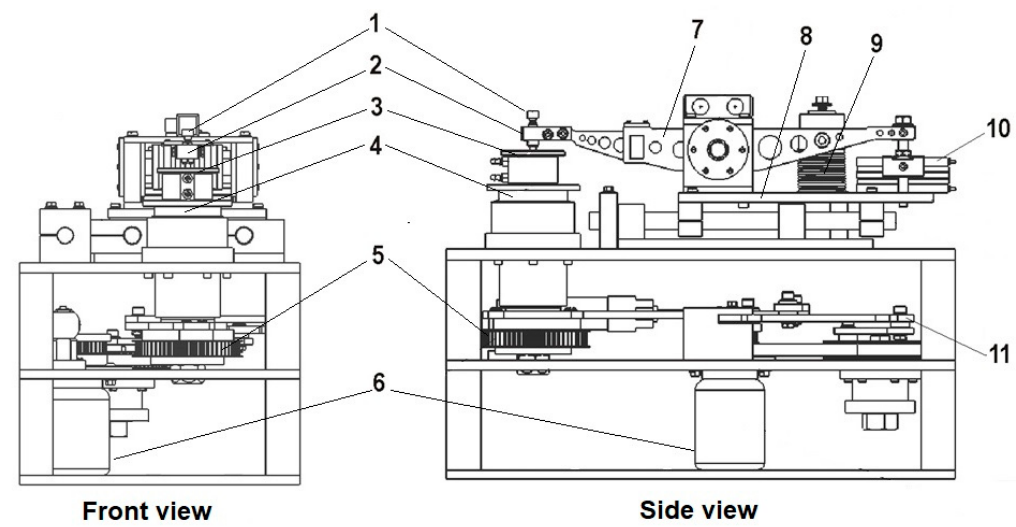
Figure 2. Schematics of the fretting tester: 1—screw, 2—countersample holder, 3—sample holder, 4—rotating table, 5—wheel driving the rotating table, 6—driving motor, 7—lever, 8—slidable table, 9—loading spring, 10—pneumatic actuator, 11—lever system.